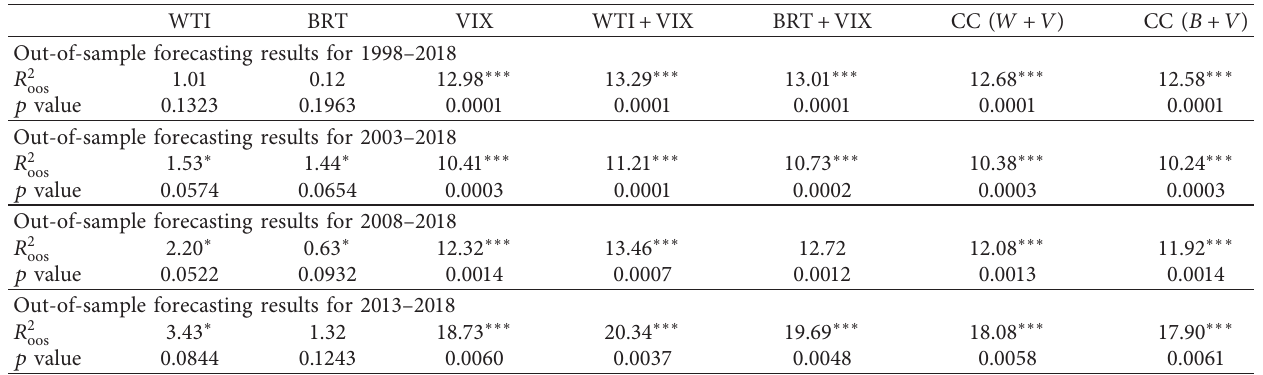
Table 3: Out-of-sample forecasting results, recursive